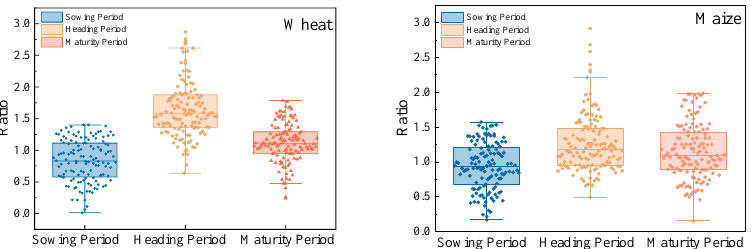
Figure 17. Variation in the ratio of actual to potential ET for different phenological periods.